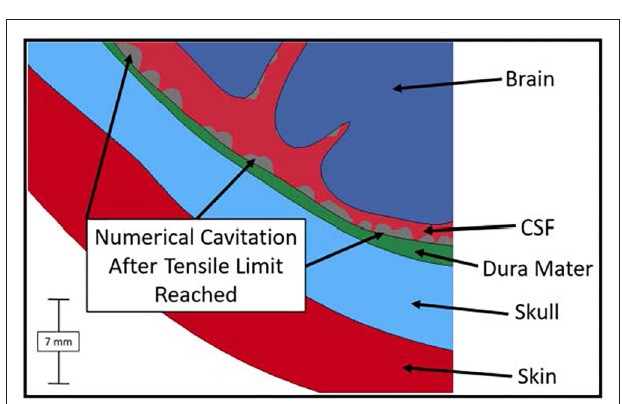
FIGURE 6 | Numerical cavitation of the CSF along the posterior and lateral portions of the skull and brain when the tensile limit of CSF is reached.